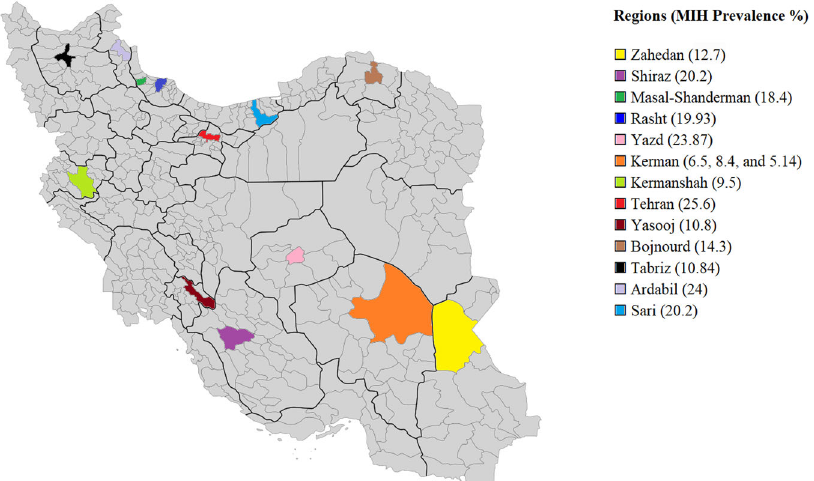
Fig. 2 Prevalence of MIH in Iran. Map highlighting the regional distribution of prevalence of MIH in Iran based on the records retrieved in the systematic